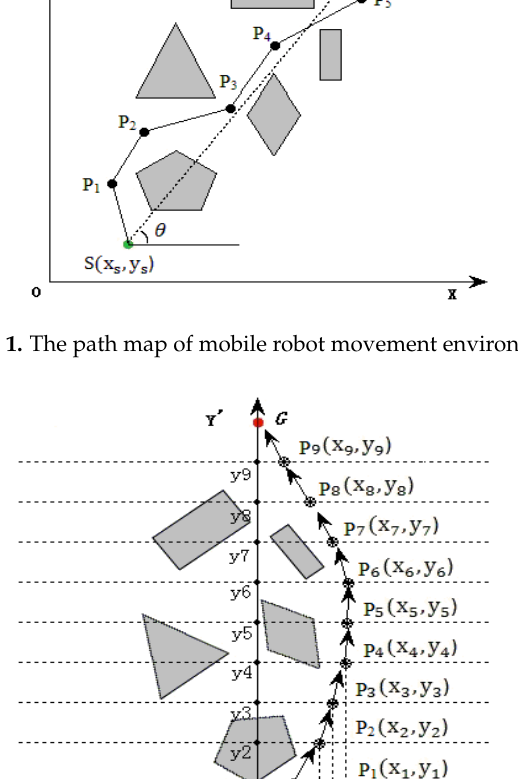
Figure 1. The path map of mobile robot movement environment.